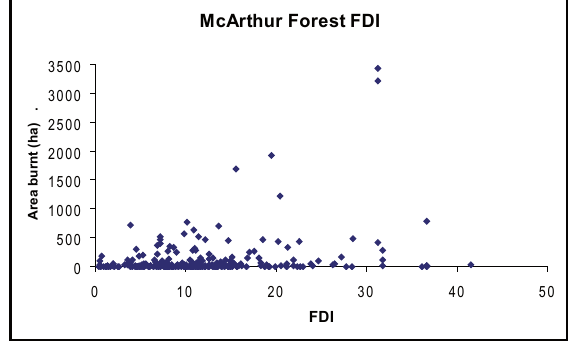
Figure 5 The fire weather conditions (as measured by the McArthur Forest Fire Danger Index, FDI) associated with fires of different sizes in the Table Mountain National Park between 1970 and